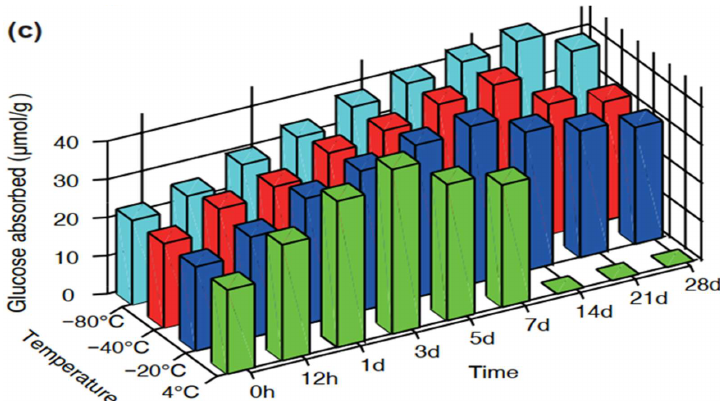
Figure 2. In vitro absorption capacities of various cooked rice samples for oil ( a ), cholesterol ( b ), and glucose ( c ). Values are the means ± SEM ( n = 3).